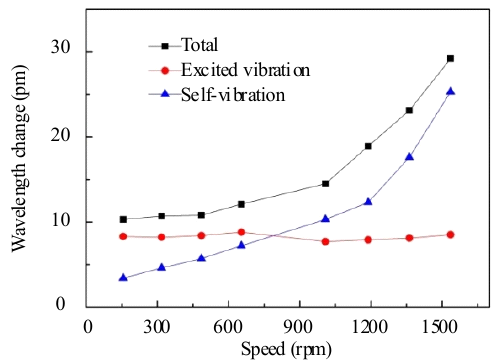
Fig. 5 Relationship between the rotational speed and wavelength of the fiber grating ( h = 0.2 mm).